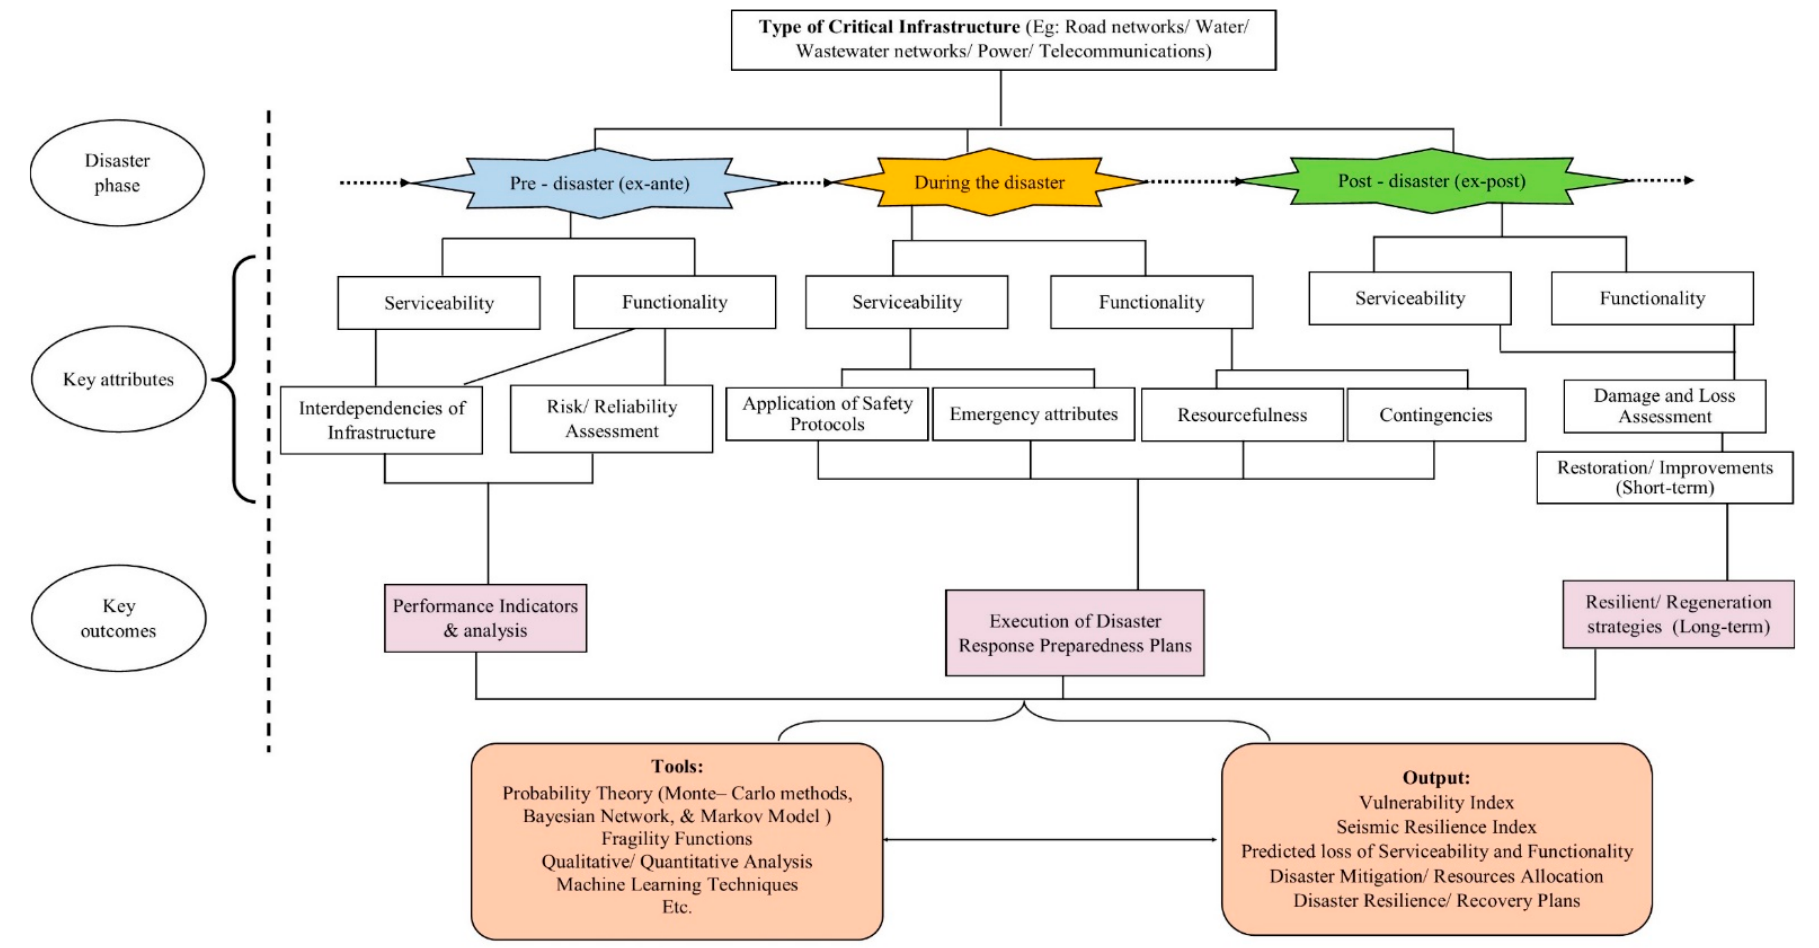
Figure 12. An overview of an integrated and adaptive framework for assessing infrastructure resilience for earthquake hazards.